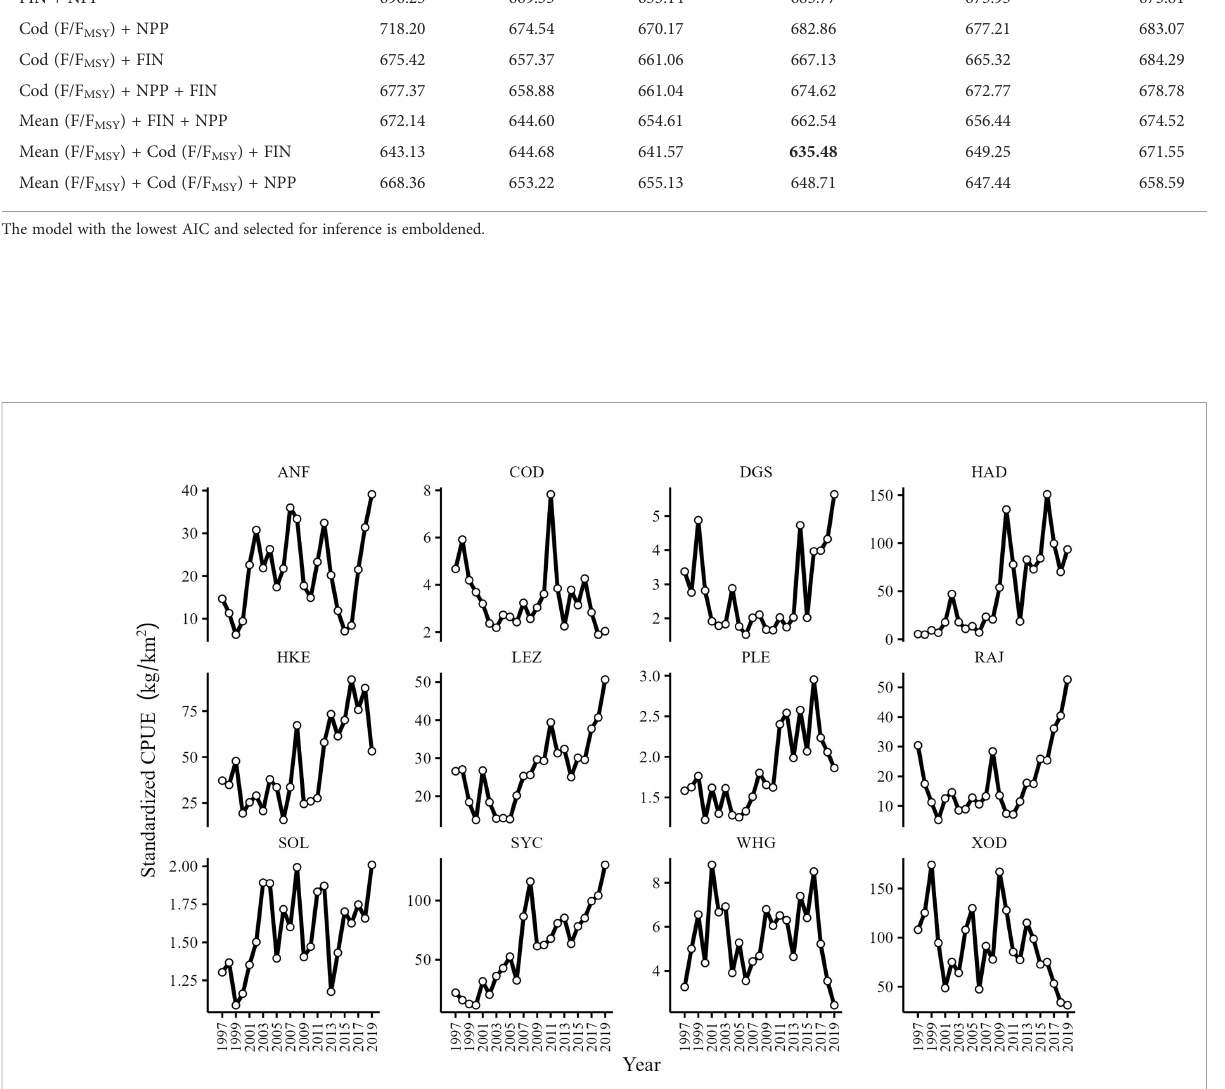
FIGURE 3 CPUE (kg/km 2 ) series of angler fi sh (ANF), cod (COD), spurdog (DGS), haddock (HAD), hake (HAK), megrim spp. (LEZ), plaice (PLE), skates and rays (RAJ), sole (SOL), lesser-spotted dog fi sh (SYC), whiting (WHG) and Trisopterus spp. (XOD) in the Celtic Sea from 1997 to 2019.